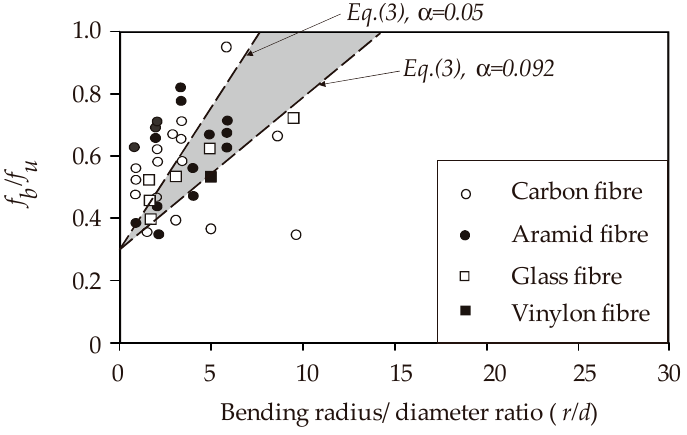
Figure 8. Bend capacity by the Japanese Society of Civil Engineering’s (JSCE’s) equation (data from JSCE document [45]).